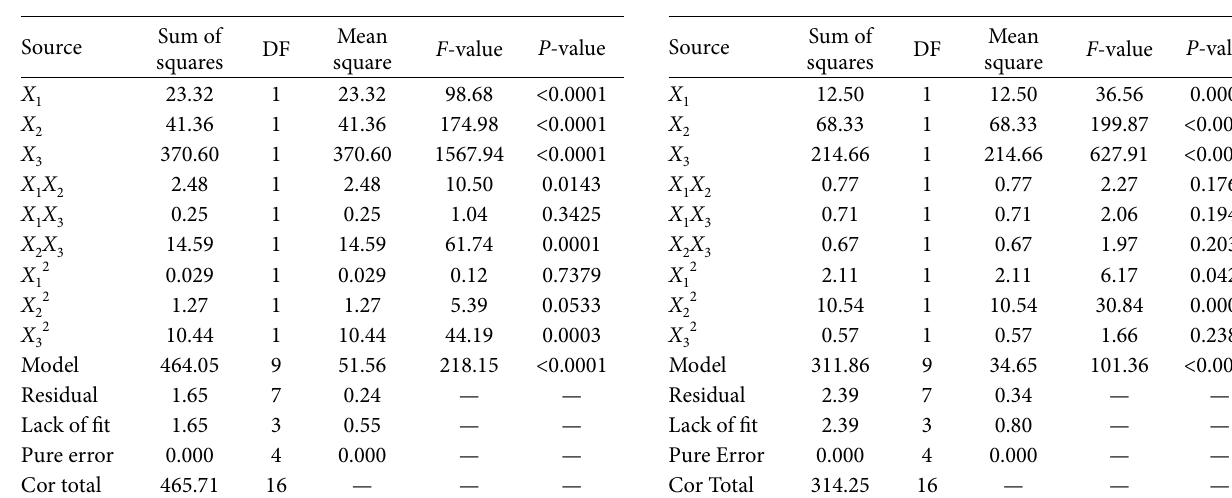
Table 2: Results of analysis of variance ( ANOVA ) for DEc.